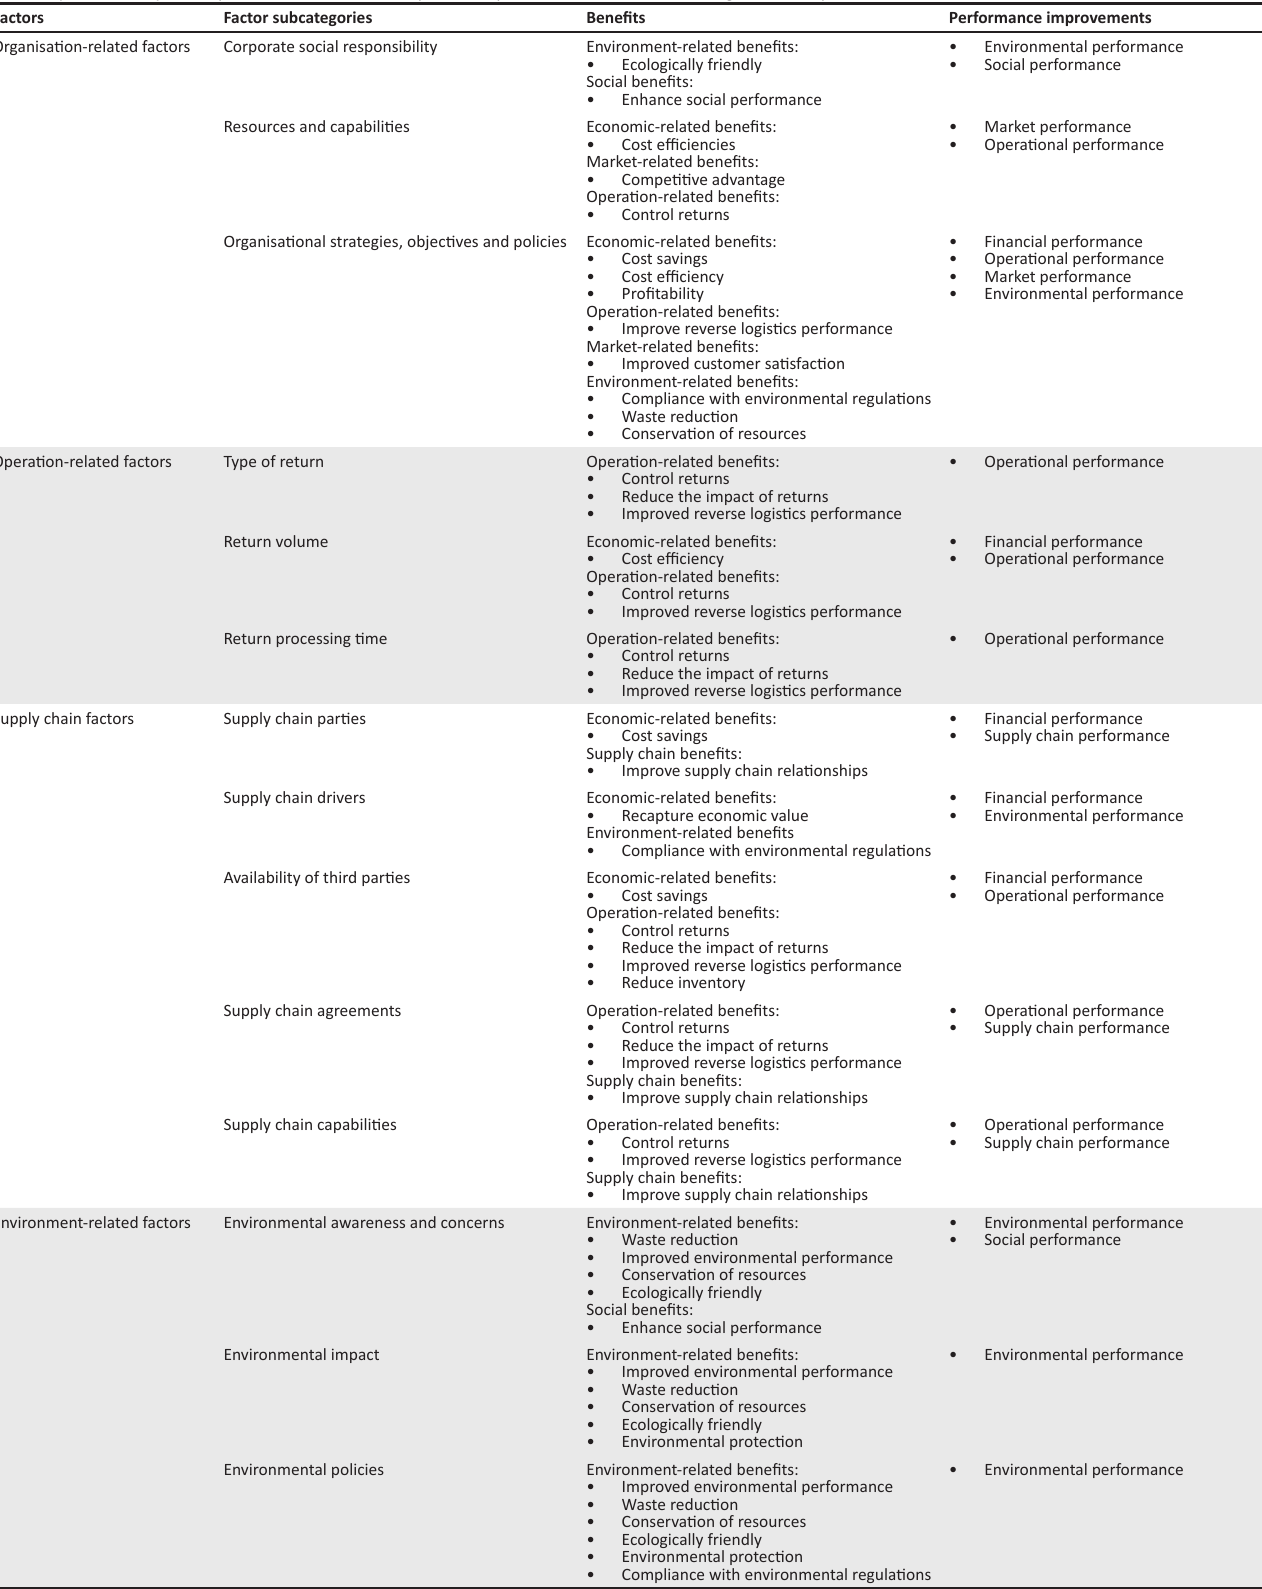
TABLE 4 (Continues...): Conceptual framework of the impact of disposition decision factors on organisational